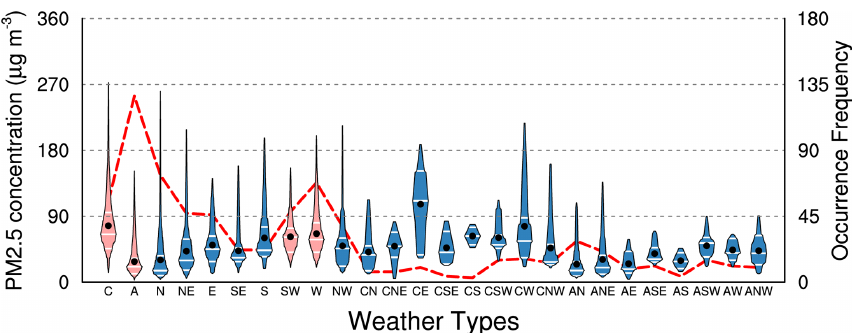
Figure 2. Daily averaged PM 2 . 5 concentration at Olympic Center station (box plots; units: 10 − 1 µgm − 3 ) and the occurrence frequencies of 26 weather types (dashed red lines) from 2018 to 2019. The red boxes represent classical types selected for research. The black dots represent the mean values.